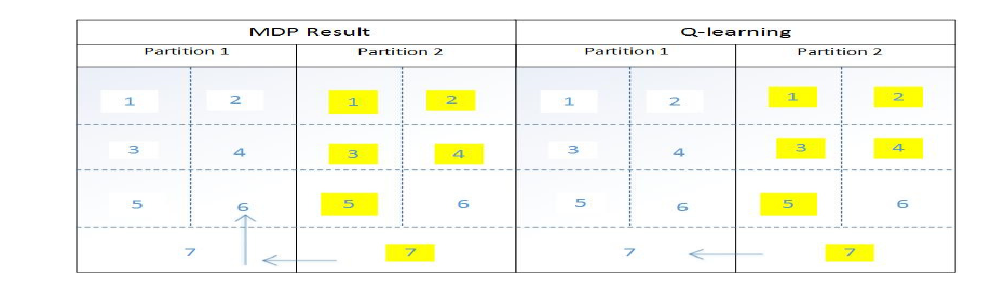
Fig. 12: Case B Local Agent